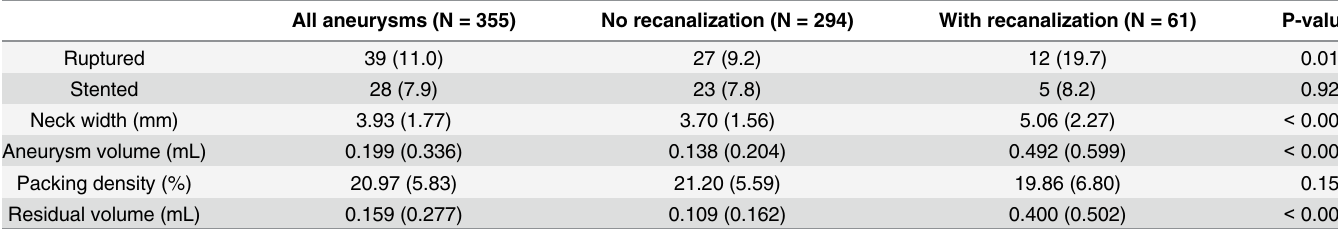
Table 1. Baseline characteristics of 355